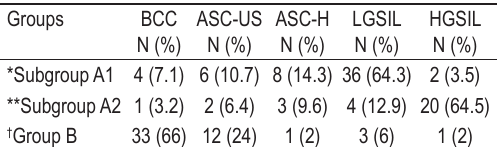
Table 2. PAP test results Groups